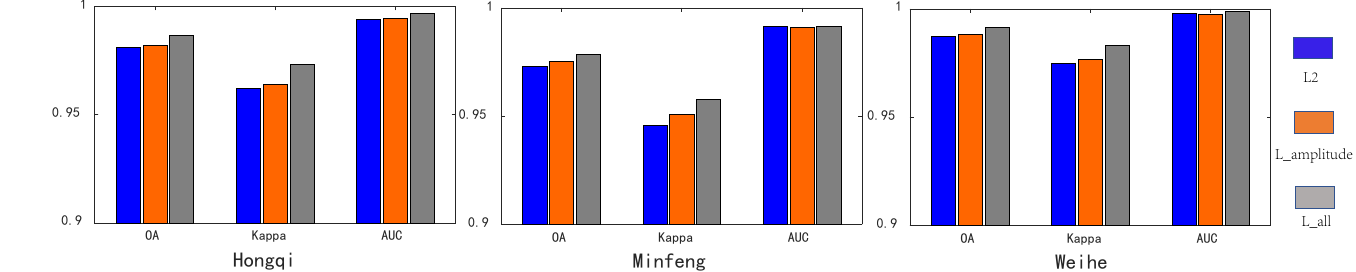
Figure 14. Comparison of the effect of different loss functions on OA, Kappa, and AUC